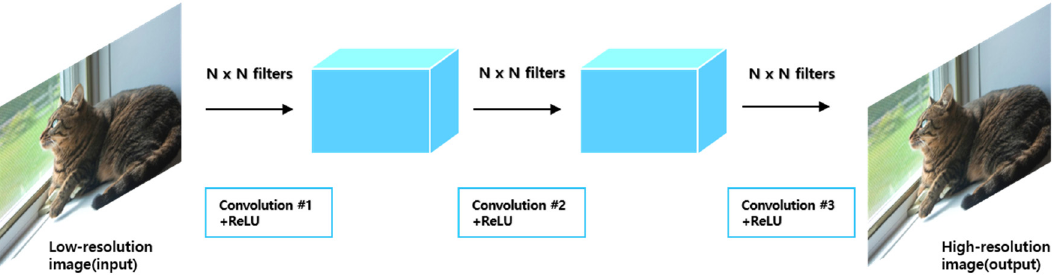
Figure 8. Convolutional Neural Networks with three layers.